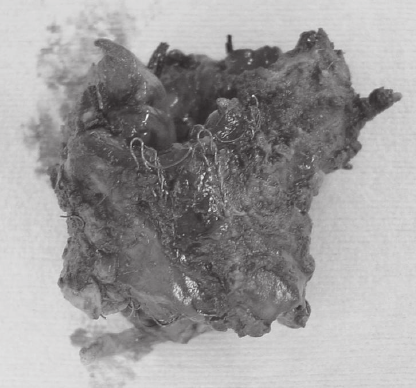
Figure 5: The stent was coiled around the extracted